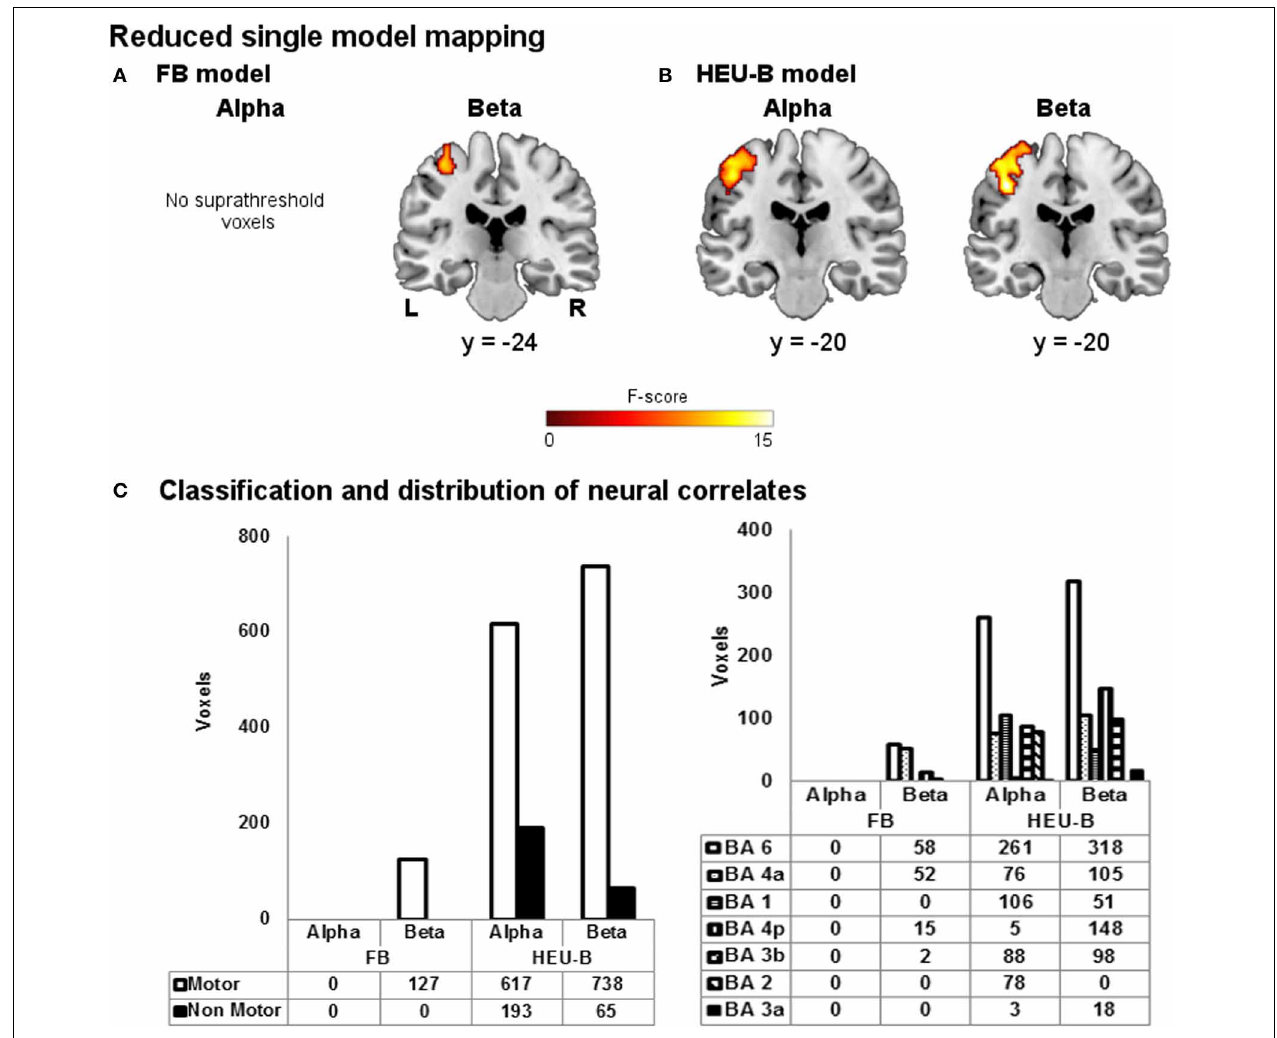
FIGURE 6 | Reduced single model mapping. Group maps obtained showing neural correlates of alpha and beta rhythms for (A) reduced FB model and (B) reduced HEU-B model (FB: p < 0 . 001, uncorrected; HEU-B on alpha: p < 0 . 001, uncorrected; HEU-B on beta: p < 0 . 05,